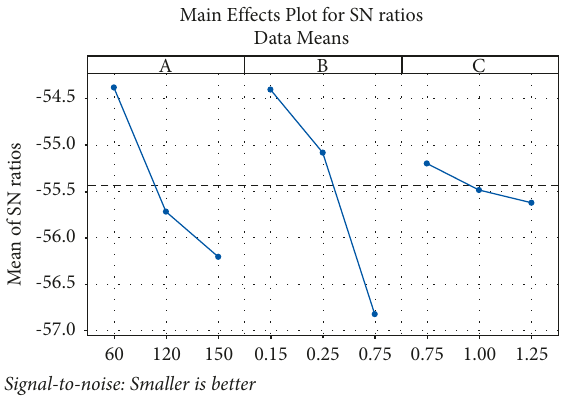
Figure 6: S/N ratio’s main effects for flank